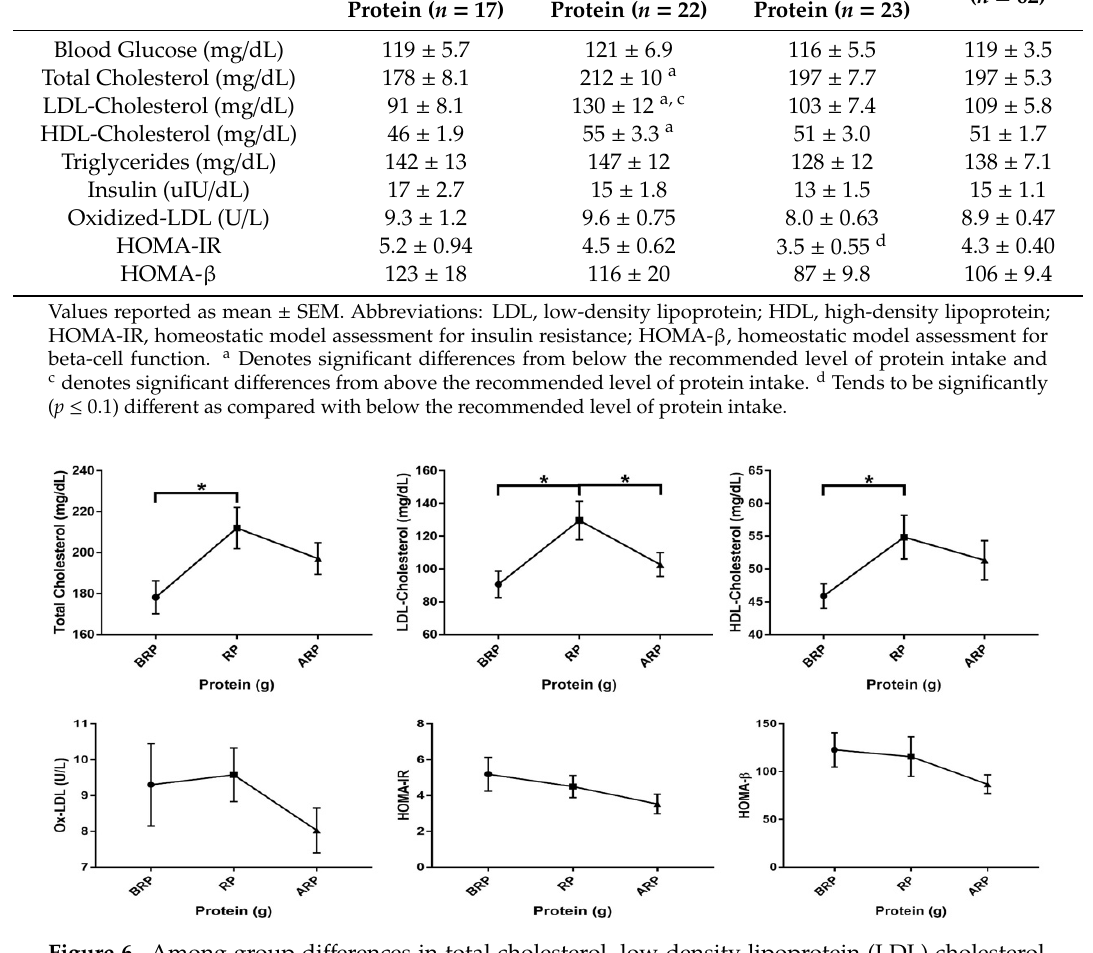
Figure 6. Among group di ff erences in total cholesterol, low-density lipoprotein (LDL) cholesterol, high-density lipoprotein (HDL) cholesterol, oxidized LDL (Ox-LDL), homeostatic model assessment for insulin resistance (HOMA-IR), and homeostatic model assessment for beta-cell function (HOMA- β ) of study participants below ( n = 17), meeting ( n = 22), and above ( n = 23) the recommended-protein groups (BRP, RP, and ARP, respectively). Values are reported as mean ± standard error of the mean (SEM). * Denotes significant di ff erences among groups ( p < 0.05).